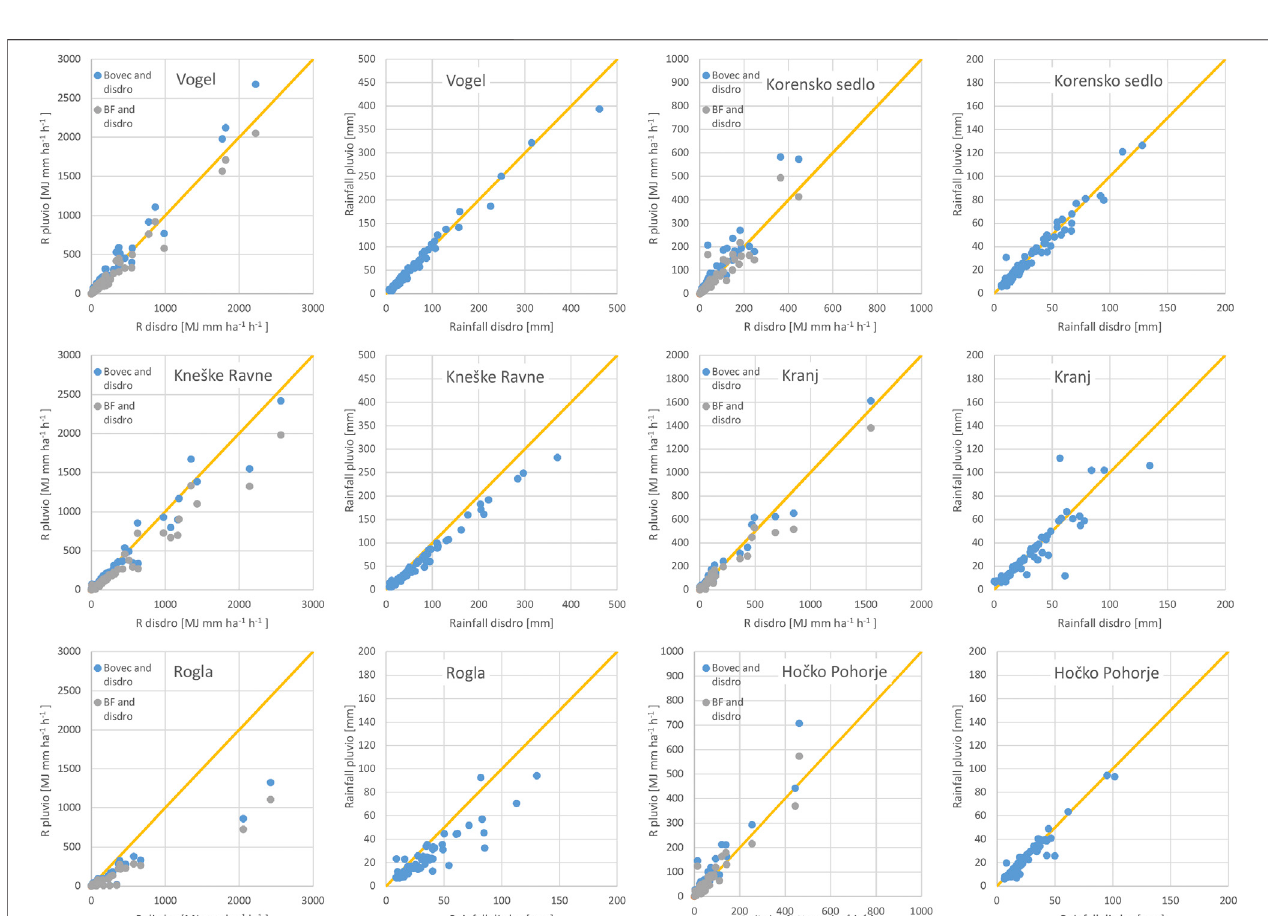
FIGURE9| Comparisonbetweenrainfallerosivitydeterminedusing1minopticaldisdrometerdataand5minpluviographsdata,where Equations4 , 5 wereused. Comparison between the event rainfall sum is also shown.